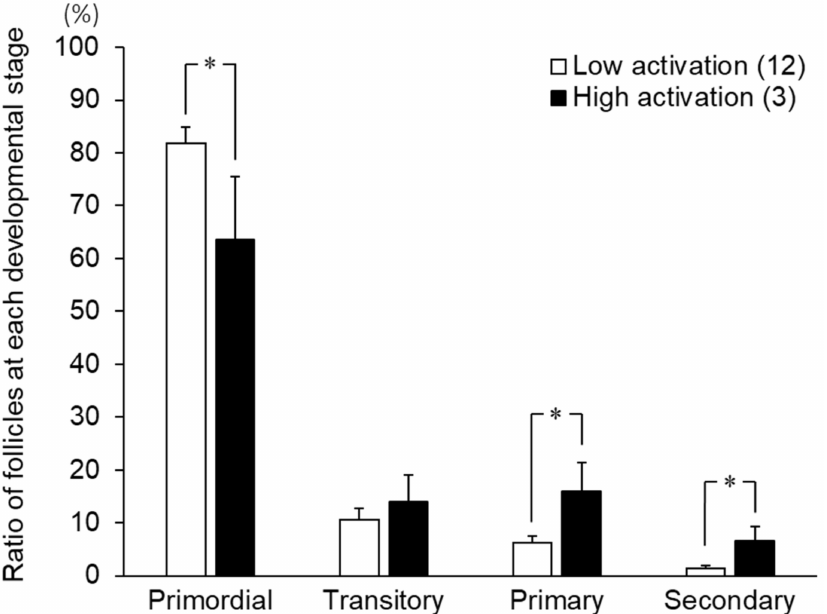
Figure 5. The ratio of follicles at each developmental stage of the low and high activation groups on day 6 of culture. * An asterisk indicates a significant difference between the low and high activation groups ( p < 0.05). Numbers in parentheses indicate the number of strips in each group. Error bars indicate the standard error of the mean